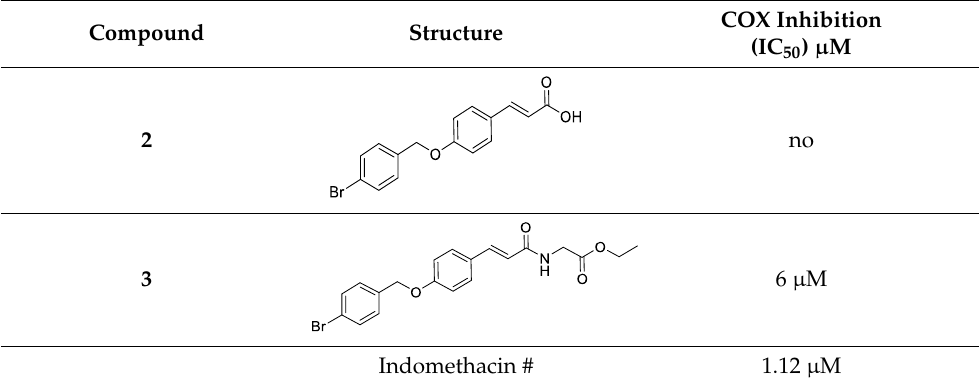
Table 2. Inhibition of ovine COX-2 (IC 50 value) for compound 3 .